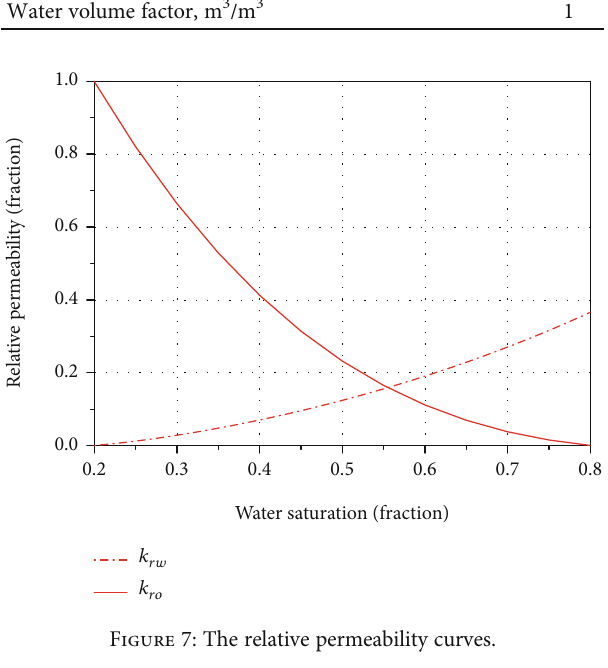
Figure 7: The relative permeability